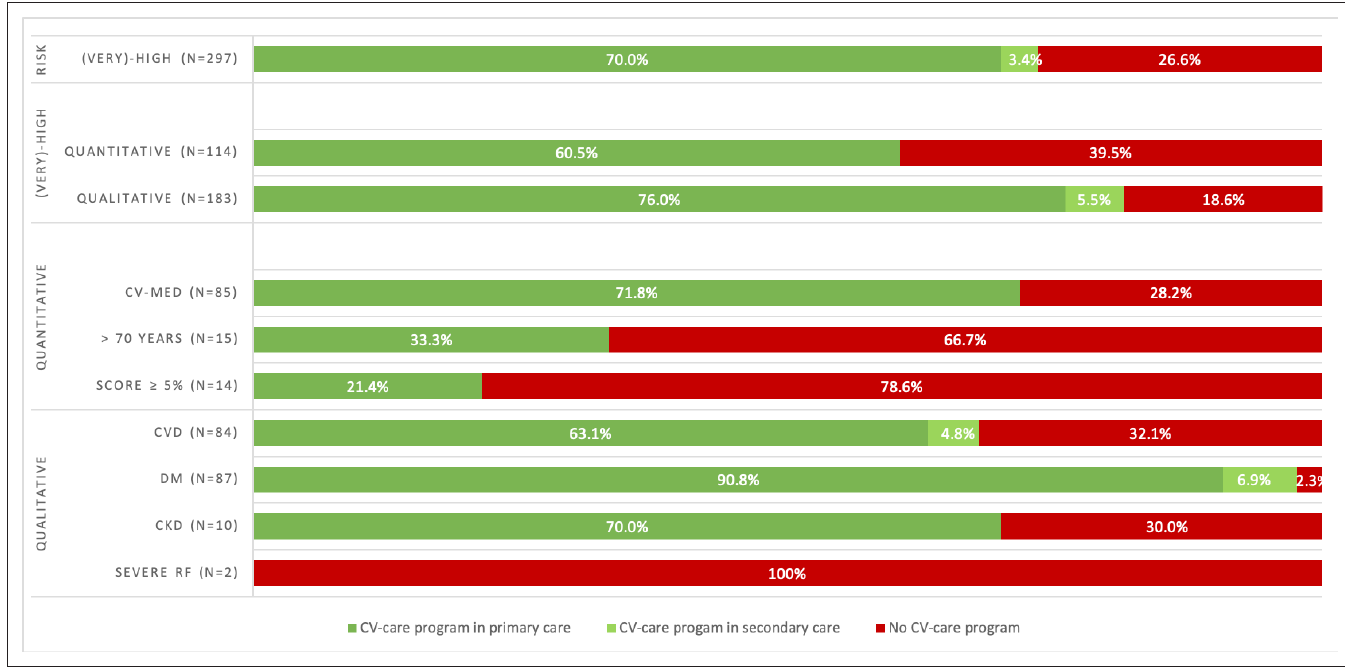
Figure 3 Cardiovascular risk and participation in cardiovascular- care programme of patients with COPD. CKD = chronic kidney disease. CV- med = cardiovascular medication. CVD = cardiovascular diseases. DM = diabetes mellitus. RF = risk factors. SCORE = Systematic Coronary Risk